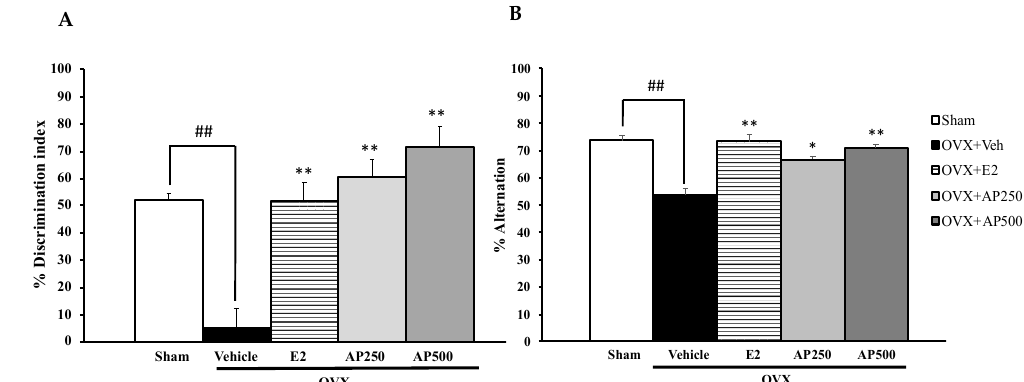
Figure 2. Effect of the AP extract on learning and memory in the sham-operated and OVX mice using the NORT ( A ) and the Y-maze test ( B ). Each column represents the mean ± SEM (n = 8–10). ## p < 0.001 vs. the sham-operated group and * p < 0.05, ** p < 0.001 vs. the OVX group (post hoc Tukey test).